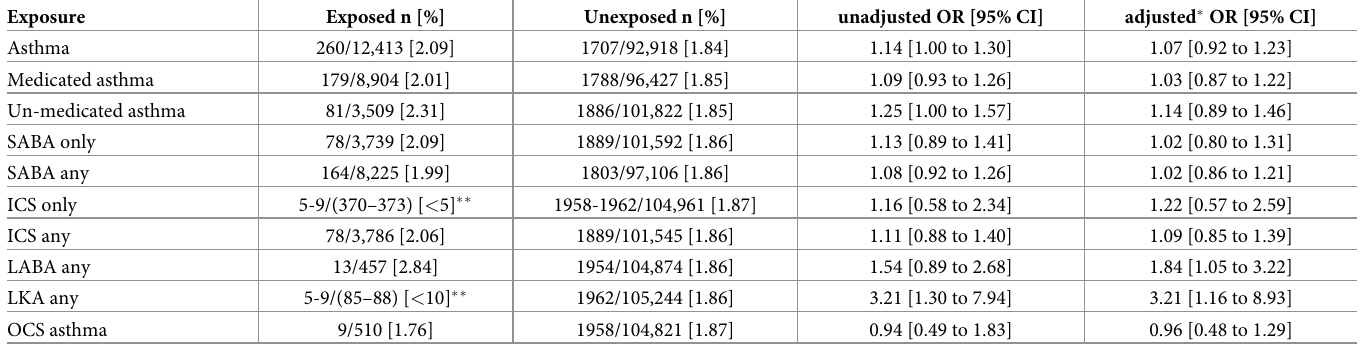
Table 5. Small for Gestational Age [SGA] < 3rd centile (n =